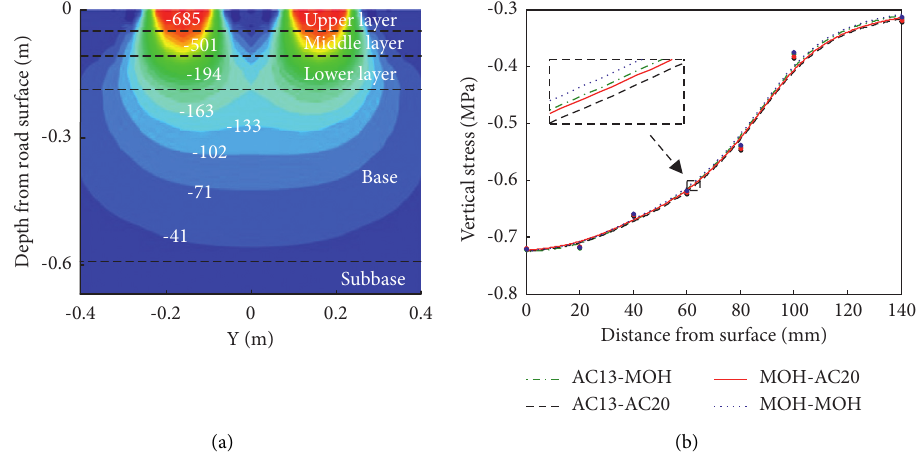
Figure 8: Vertical stress. (a) MOH-MOH. (b) Surface layer. Table 2: Deformation of the surface layer under 10 5 load cycles.